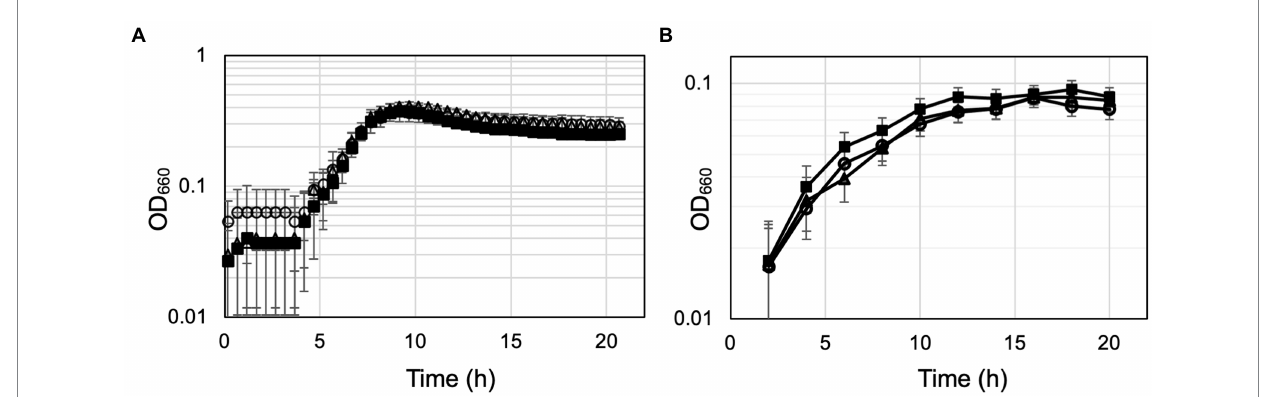
FIGURE 6 Growth properties of the host strain KU216 and the gene disruption strains. Growth of the host KU216 strain (closed squares) and the Δ TK0548 (open triangles) and Δ TK2248 (open circles) gene disruption strains were examined in a nutrient-rich ASW-YT-m1-S 0 medium containing yeast extract and tryptone (A) , and in a synthetic amino acid medium ASW-AA-m1-S 0 (+Ura) (B) . Growth was measured at 85 ° C. Error bars indicate the standard deviations of three independent culture experiments. The vertical axis is represented in logarithmic